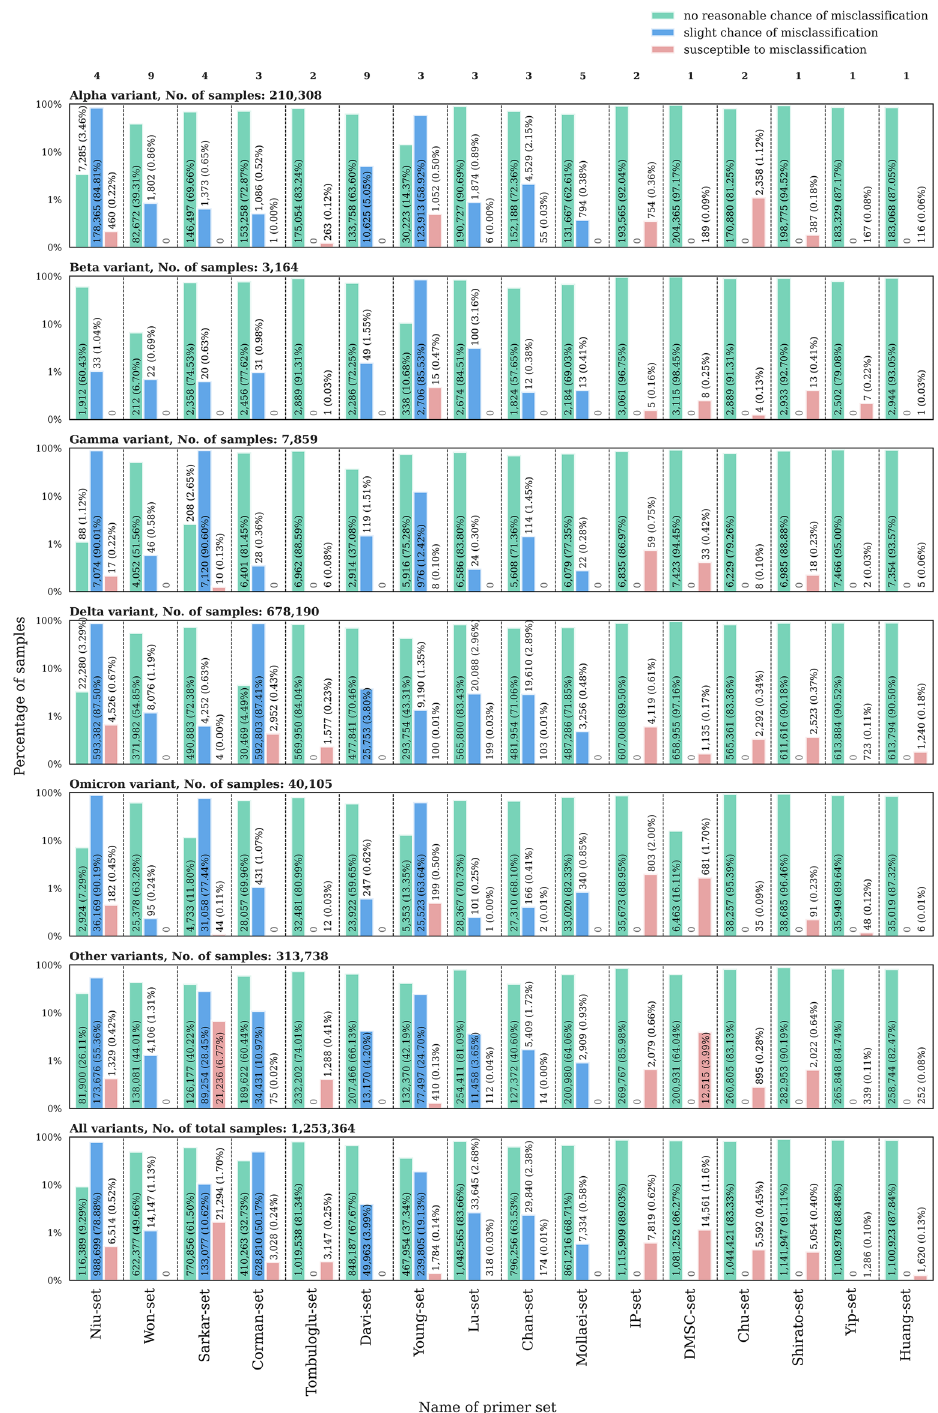
Figure 4. Percentage and number of samples having no reasonable chance (light green) or a slight chance of misclassification (light blue) or being susceptible to (light red) misclassification by different primer sets. Numbers on top indicate the number of primer systems present in a given primer set. Primer-set names are based on the nomenclature: [first author last name]-[set]. Ambiguous samples with unsatisfactory coverage in TRs are not shown. For a modified version of the figure with linear vertical axes, see Supplementary Fig.